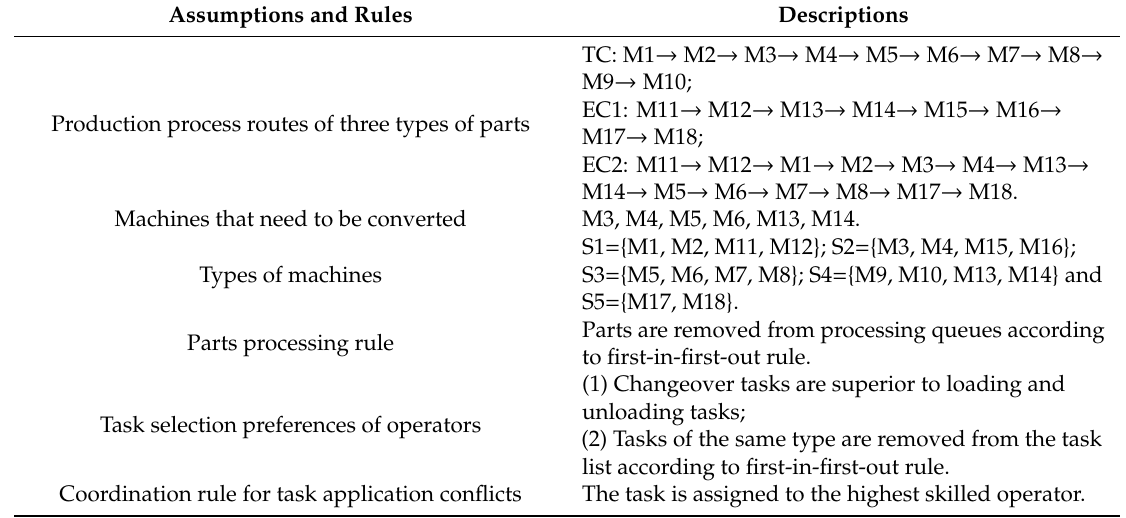
Table 1. Assumptions and rules in the simulation